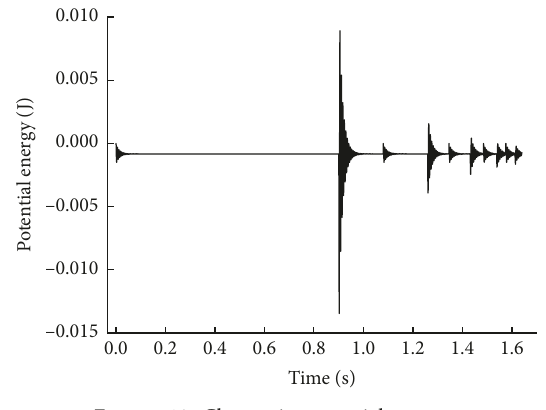
Figure 19: Change in potential energy.